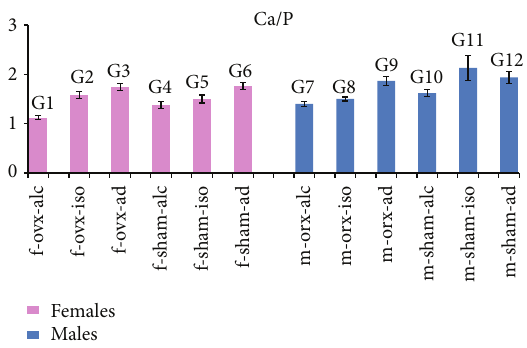
Figure 4: Ca/P: the graph illustrates the values of the averages (bars) and standard deviations (lines superimposing the bars). Statisti- cal comparisons are summarized as follows: females: comparison between most of the groups showed statistical significance ( 𝑝 < 0.05 ). No significant differences (NS) were observed in the following groups: G3/G6 (NS). Males: comparison between mostof thegroups showed statistical significance ( 𝑝 < 0.05 ). No significant differences (NS) were observed in the following groups: G12/G9 (NS); G12/G11